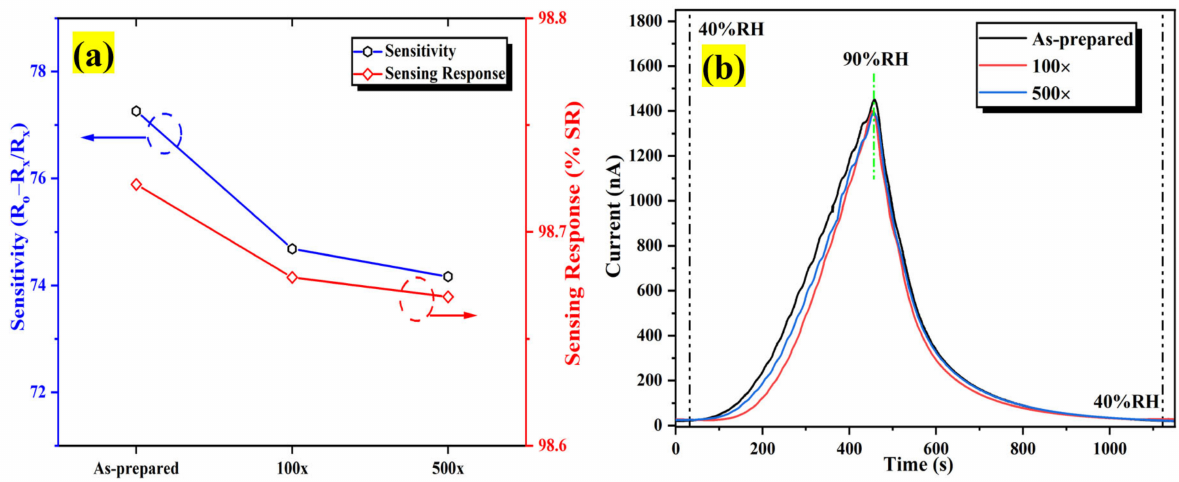
Figure 20. The influence of bending assessment on the performance of the humidity sensor ( a ) sensitivity and ( b ) dynamic sensing response variation after distinct bending